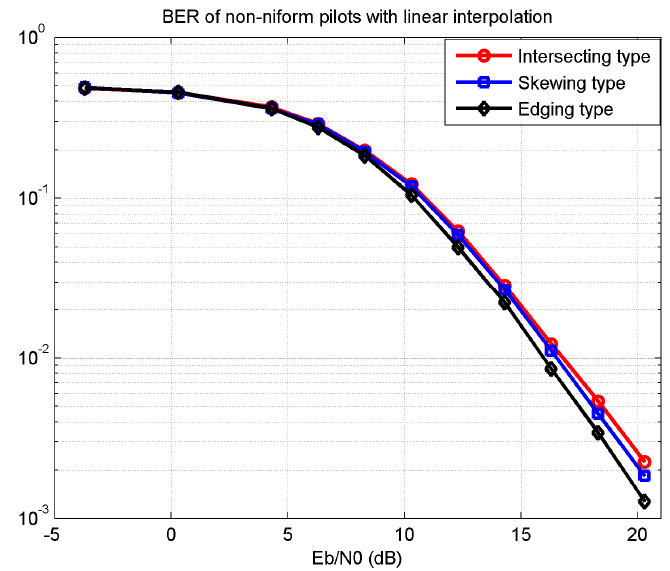
Figure 6. BER of non-uniform pilots with linear interpolation.